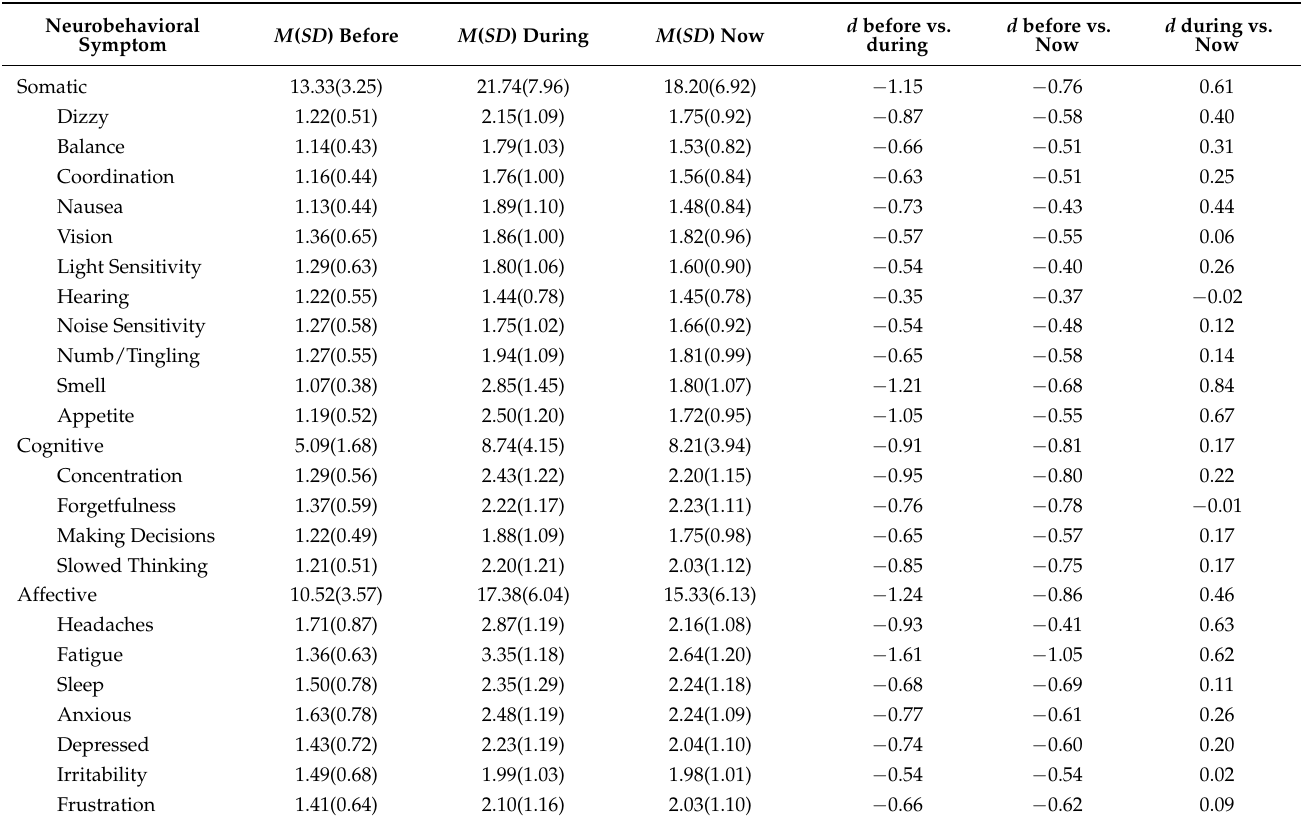
Table 2. Neurobehavioral symptoms before COVID-19 diagnosis, during COVID-19 infection, and now (N =